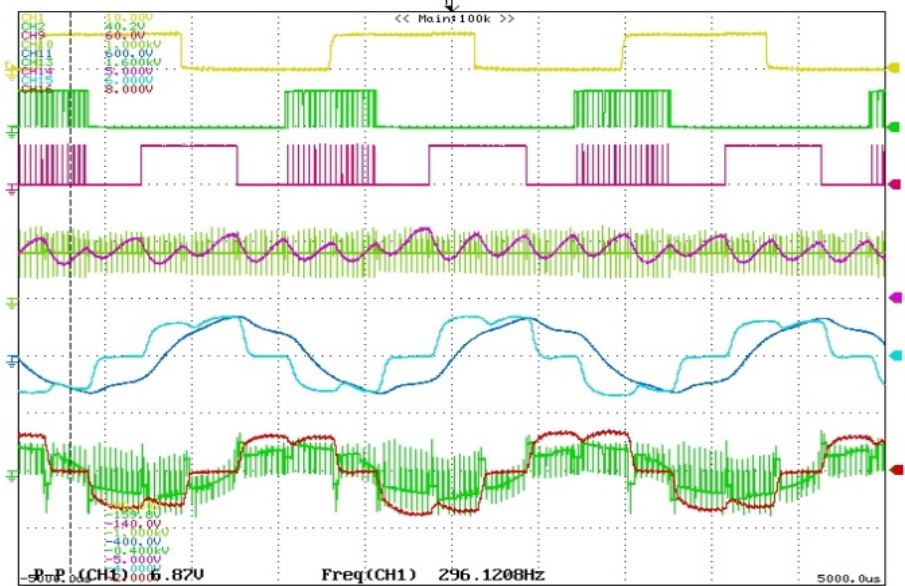
Figure 18. Phase currents, phase voltages with lead angle adjustment Vs time at 70% duty cycle.